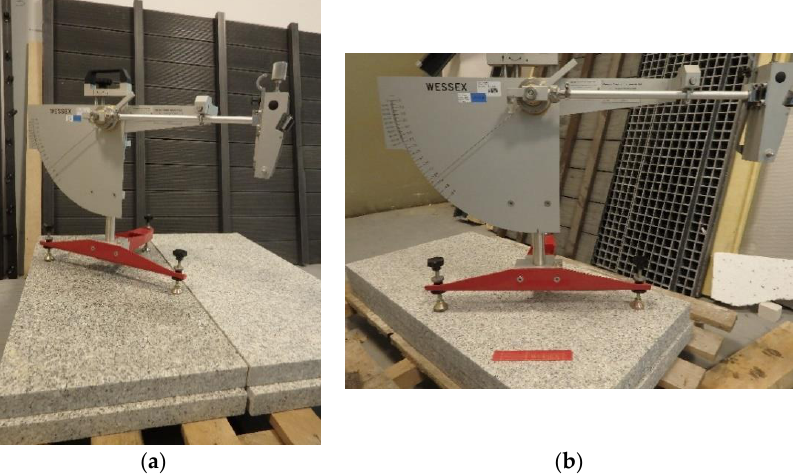
Figure 5. SRV test: ( a ) polished granite slabs (PO) in wet condition, ( b ) brushed granite slabs (SZ) in dry condition.